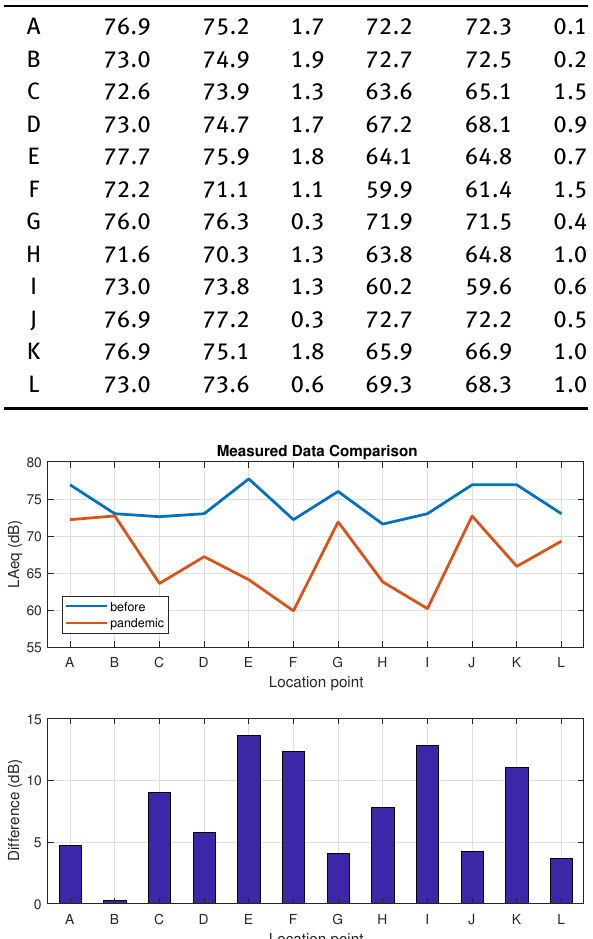
dB, which is in agreement with the expected drop of 50% of traffic flow at these